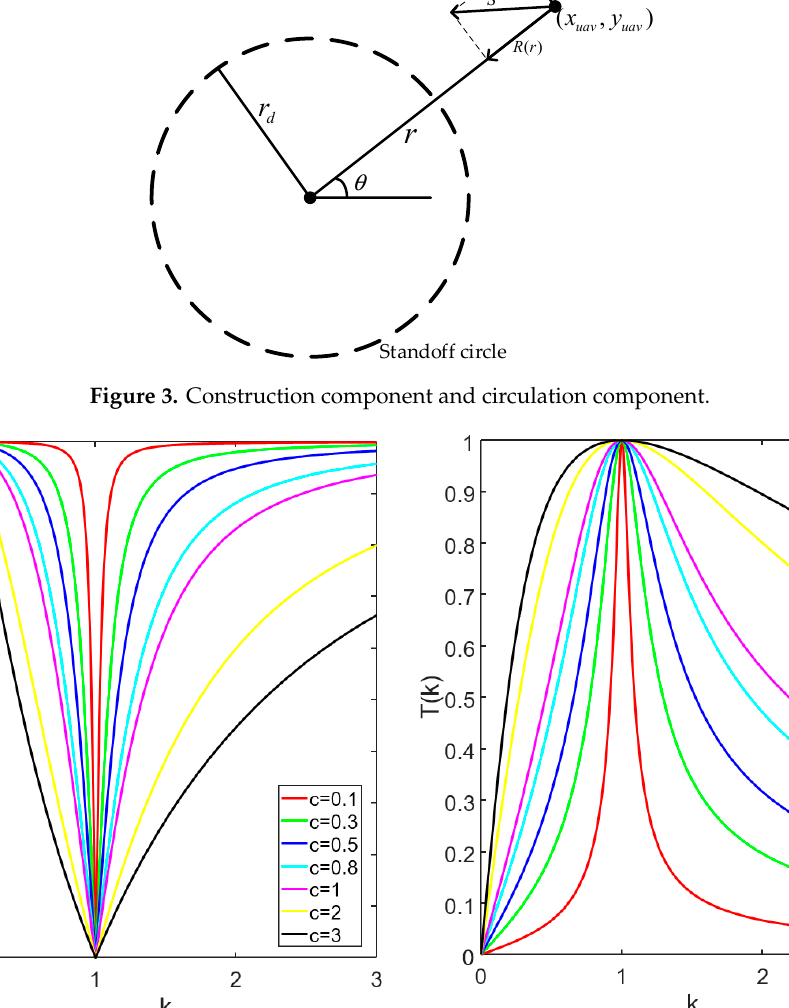
Figure 4. Curves of contraction and circulation components versus k in different c . ( a ) Curves of contraction component versus k ; ( b ) Curves of circulation component versus k .